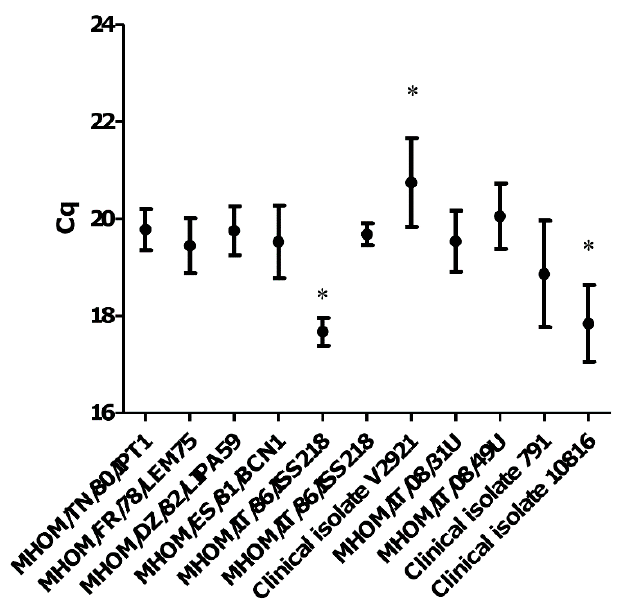
Figure 2. qPCR-ML Cq values obtained from 11 L. ( L .) infantum strains / isolates. The results were obtained from six independent experiments. * p < 0.01 Dunn’s Multiple Comparison Test.